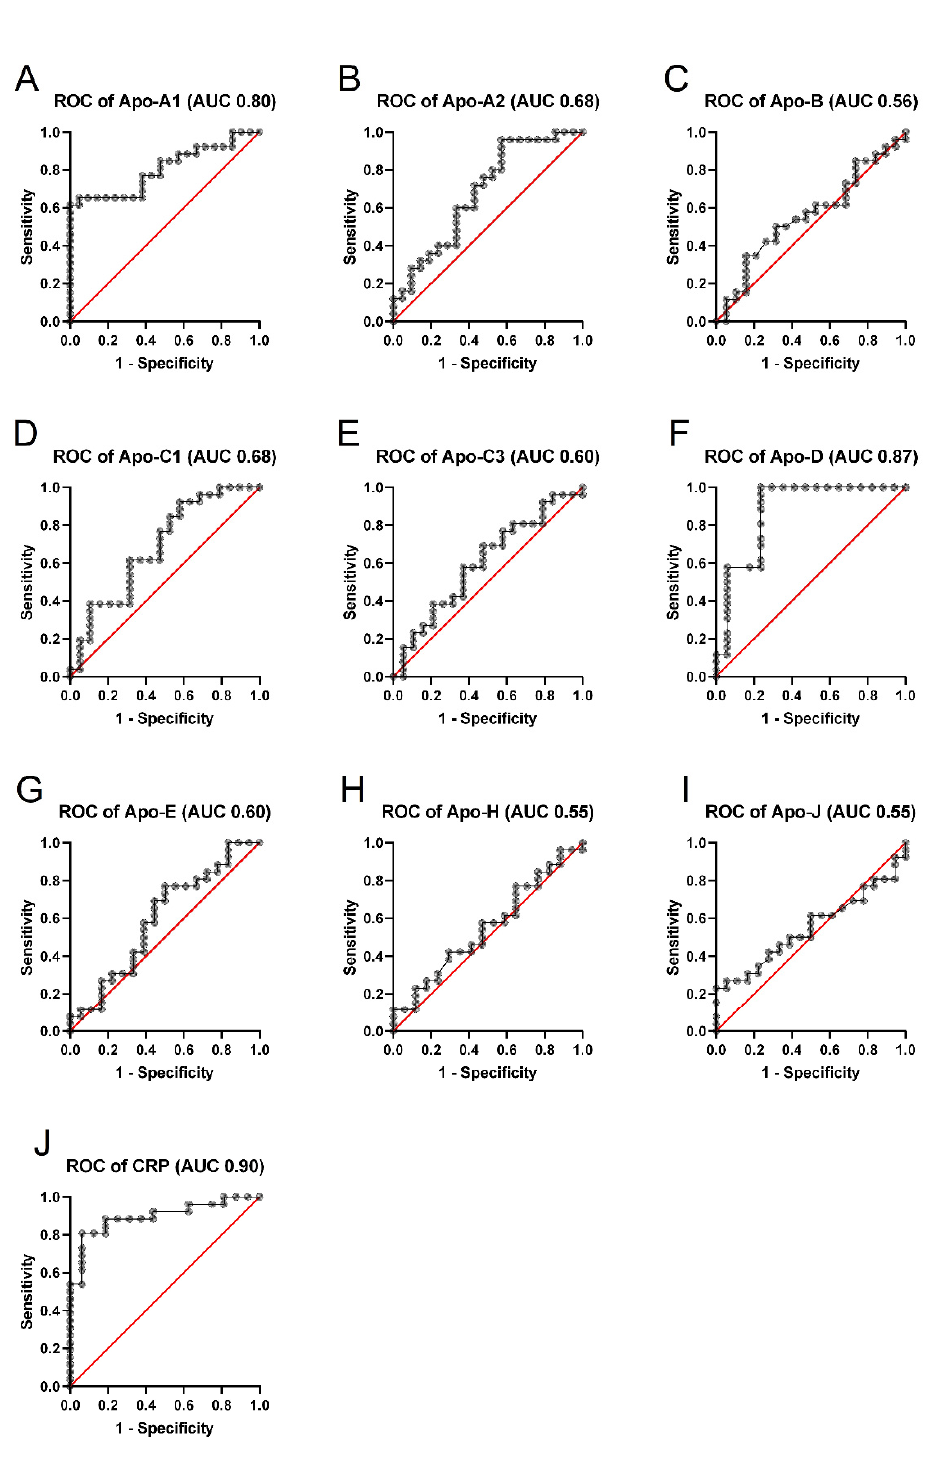
Figure 2. The receiver operating characteristic (ROC) analysis for the prediction of abnormal weight (i.e., overweight/obese) based on the concentrations of apolipoproteins—i.e., ( A ) apolipoprotein A1, ( B ) apolipoprotein A2, ( C ) apolipoprotein B, ( D ) apolipoprotein C1, ( E ) apolipoprotein C3, ( F ) apolipoprotein D, ( G ) apolipoprotein E, ( H ) apolipoprotein H, ( I ) apolipoprotein J—and ( J ) C-reactive protein in acute lymphoblastic leukemia (ALL) survivors.